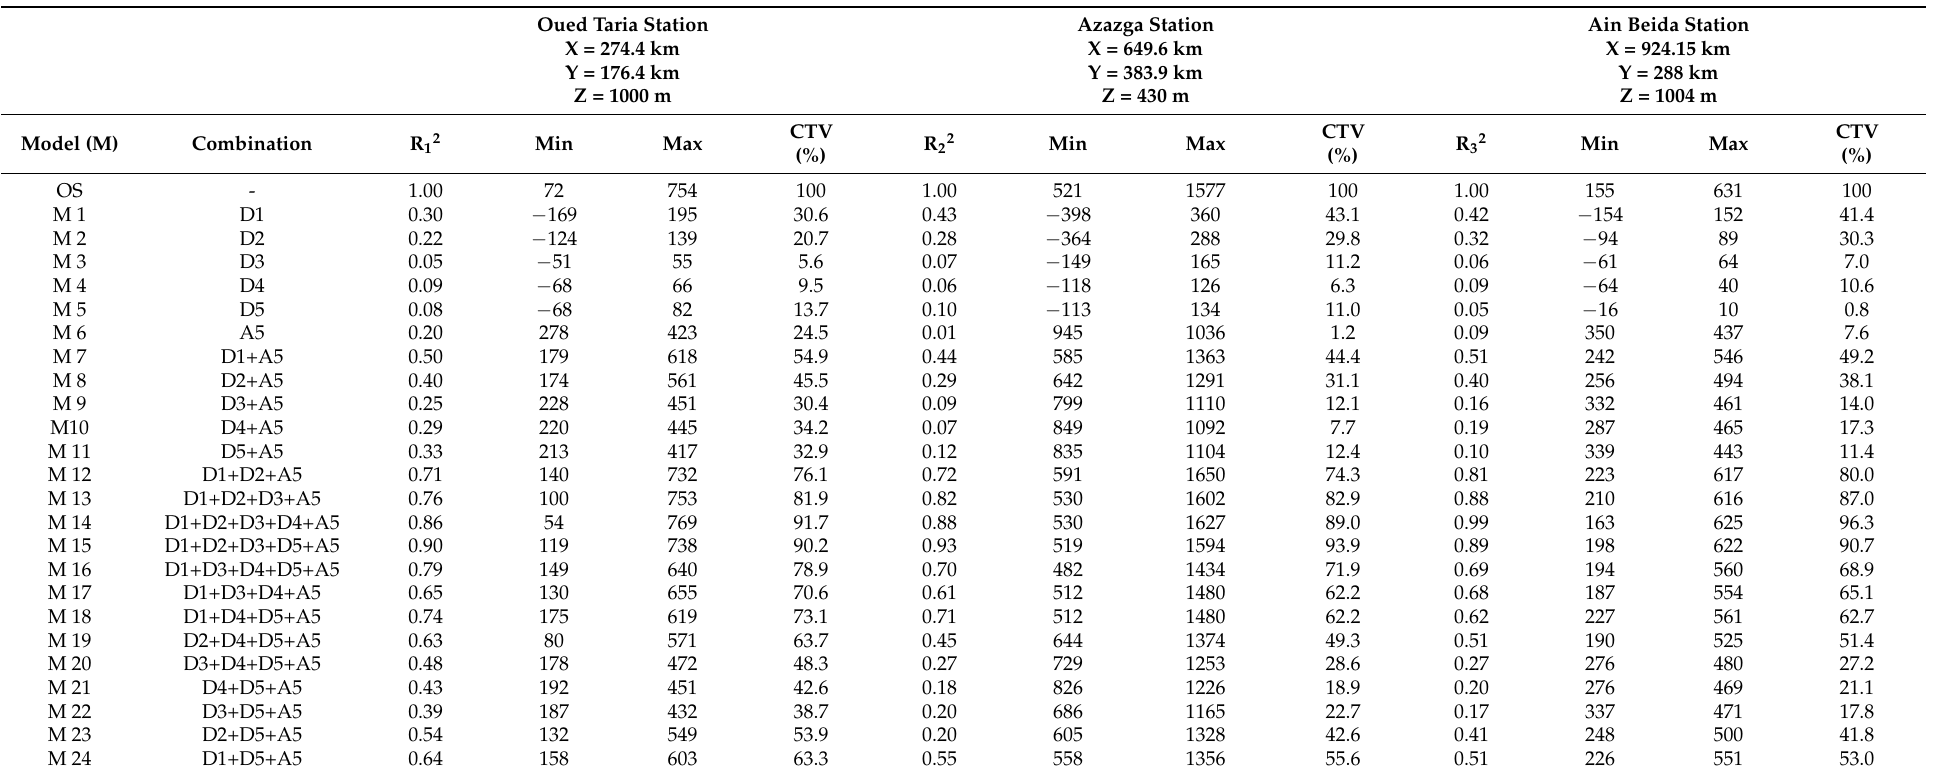
Table 2. Geographic, statistical, and nonlinear characteristics of the rainfall series and their 24 proposed models resulting from the discrete wavelet analysis. Oued Taria Station X = 274.4